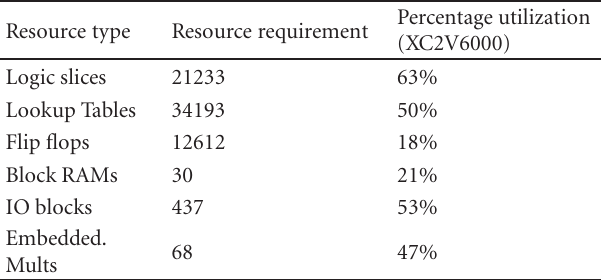
Table 4: Logic resources for classification